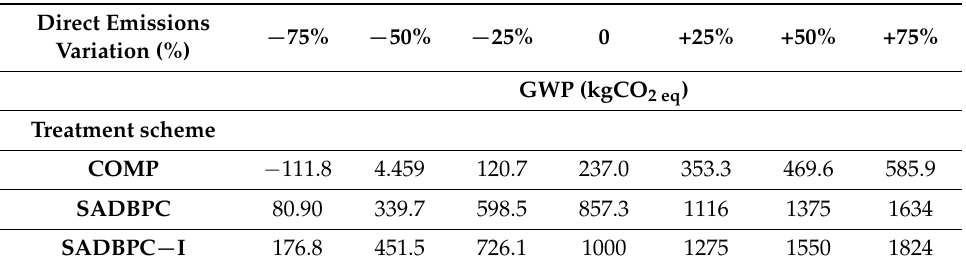
Table 6. The kgCO 2 eq emitted per Mg of organic fraction for different values of direct emissions of the different treatment schemes (Table